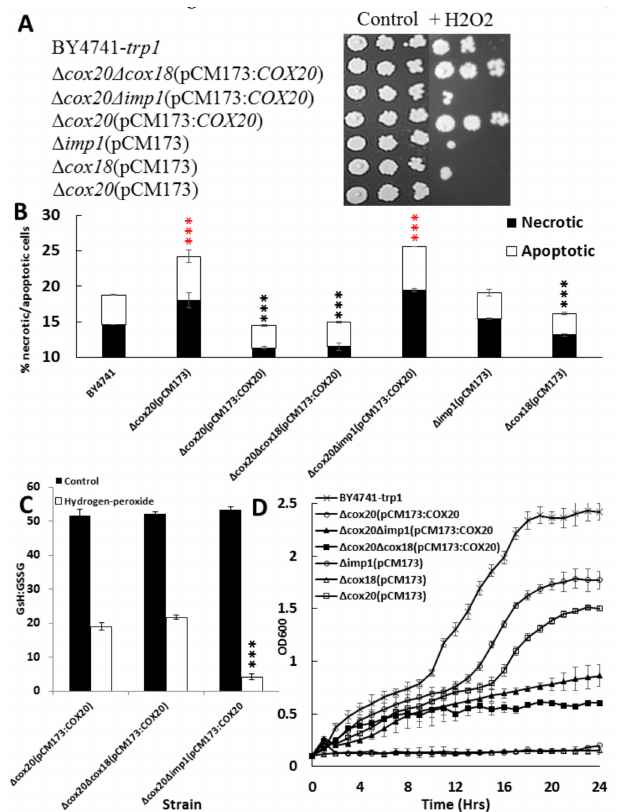
Figure 6. ( A ) Results of spot plate assay for yeast strains ∆ cox20 (pCM173), ∆ cox18 (pCM173), ∆ imp1 (pCM173), ∆ cox20 (pCM173: COX20 ), ∆ cox20 ∆ cox18 (pCM173: COX20 ), ∆ cox20 ∆ imp1 (pCM173: COX20 ) under control and in the presence of 1 mM hydrogen peroxide (HP) (10 7 -10 5 cells / mL), ( B ) Percentage of apoptotic and necrotic cells of strains BY4741, ∆ cox20 (pCM173), ∆ cox18 (pCM173), ∆ imp1 (pCM173), ∆ cox20 (pCM173: COX20 ), ∆ cox20 ∆ cox18 (pCM173: COX20 ), ∆ cox20 ∆ imp1 (pCM173: COX20 ) in the presence of 1 mM hydrogen peroxide, (C) GSH:GSSG ratio for ∆ cox20 (pCM173: COX20 ), ∆ cox20 ∆ cox18 (pCM173: COX20 ) and ∆ cox20 ∆ imp1 (pCM173: COX20 ) under control and in the presence of 1 mM hydrogenperoxide, ( D )growthon2%glycerolfor ∆ cox20 (pCM173), ∆ cox18 (pCM173), ∆ imp1 (pCM173), ∆ cox20 (pCM173: COX20 ), ∆ cox20 ∆ cox18 (pCM173: COX20 ), and ∆ cox20 ∆ imp1 (pCM173: COX20 ). Data, where appropriate, show averages of triplicate assays with the standard deviation shown ( n = 3). Red asterisks indicate that there was a significant di ff erence between BY4741- trp1 and BY4741- trp1 ∆ cox20 (pCM173:COX20), black asterisks indicate a significant di ff erence between BY4741- trp1 and BY4741- trp1 ∆ cox20